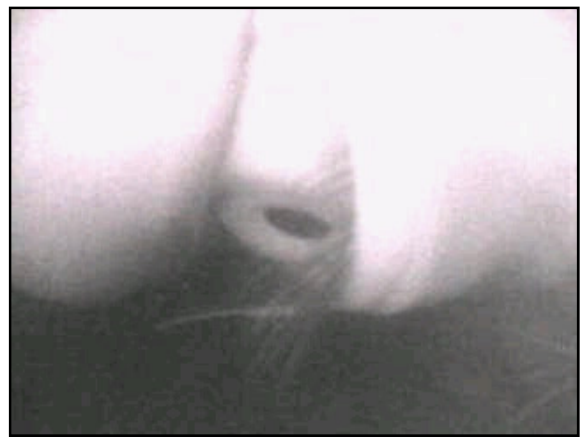
Figure 52. Eyelashes block the pupil.